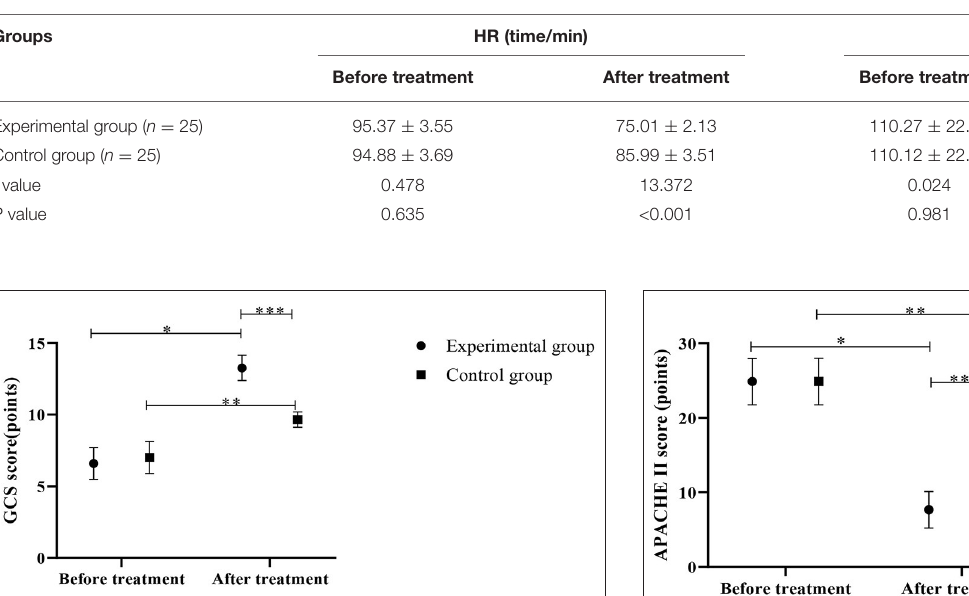
FIGURE 3 | Comparison of APACHE II scores between the control group and the experimental group (Mean, SD). The abscissa represents before and after the treatment, and the ordinate represents APACHE II score, points; the APACHE II scores of patients in the experimental group before and after the treatment were (24.88 ± 3.11) points and (7.65 ± 2.45) points respectively; the APACHE II scores of the control group before and after the treatment were (24.89 ± 3.12) points and (19.88 ± 2.95) points respectively; * Indicates that there is a significant difference in the APACHE II scores of the experimental group before and after the treatment ( t = 21.759, P < 0.001); ** Indicates that there is a significant difference in the APACHE II scores of the control group before and after the treatment ( t = 5.834, P < 0.001); *** Indicates that there is a significant difference in the APACHE II scores of the two groups of patients after the treatment ( t = 15.946, P <